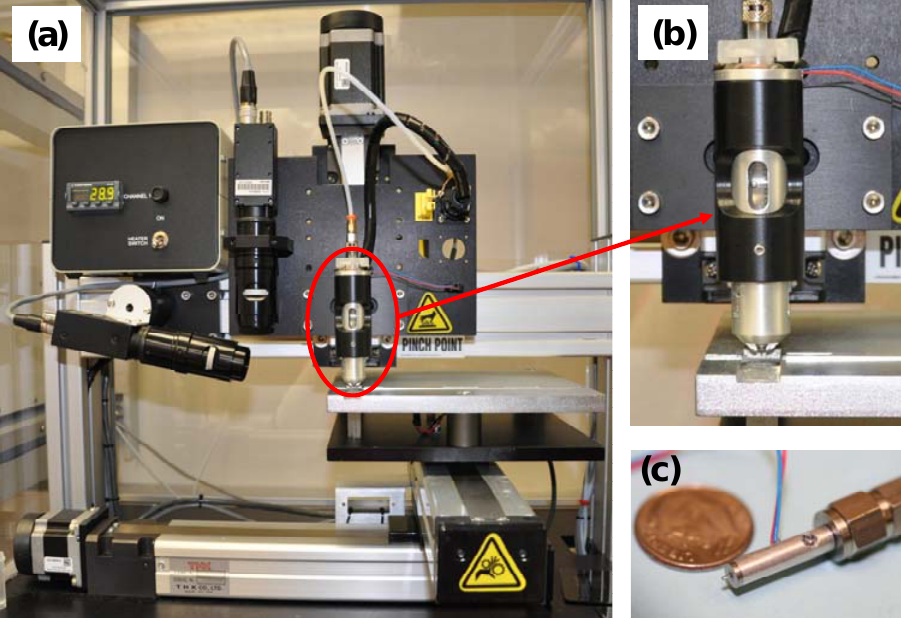
Figure 1. Photographs of ( a ) JetLab ® 4 drop-on-demand inkjet printing platform; ( b ) dispensing device and ink solution encasement; and ( c ) print head